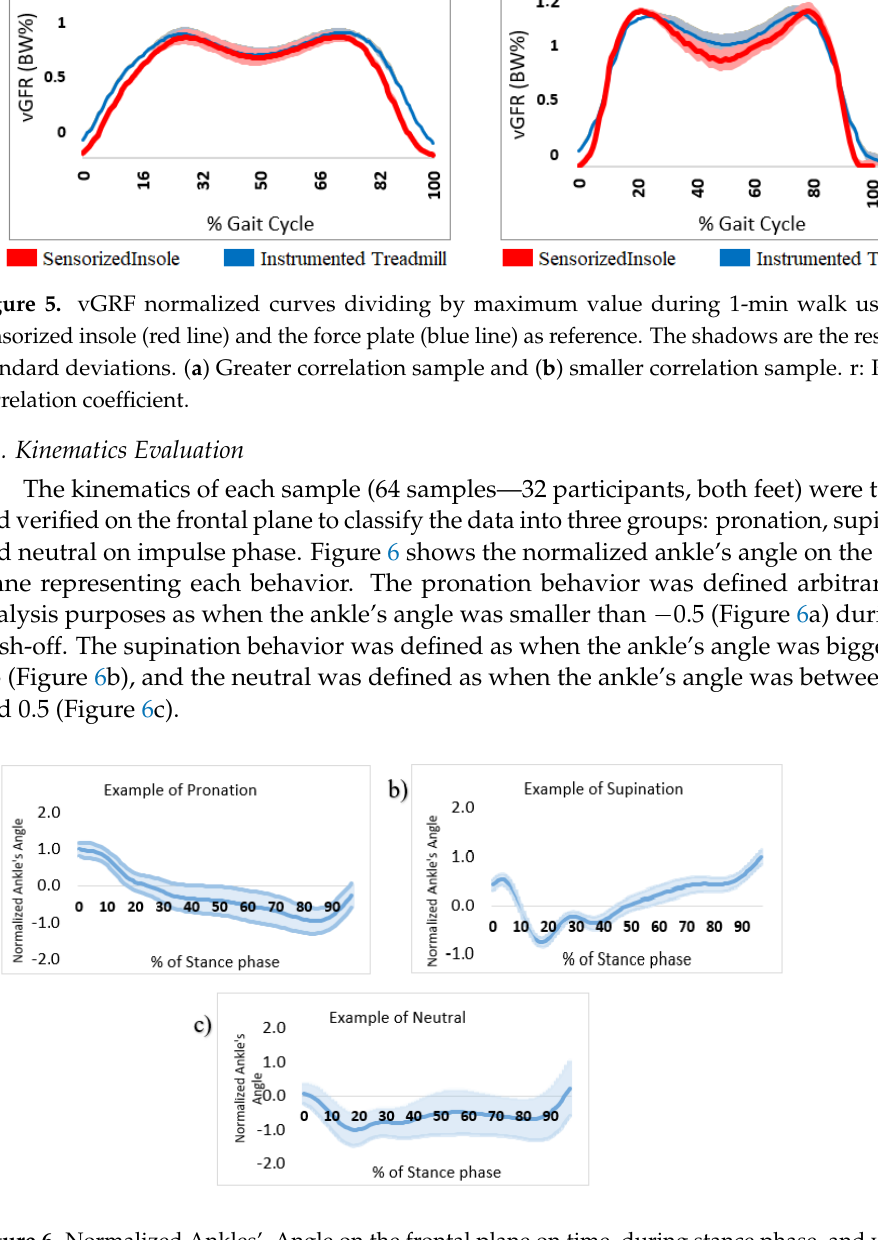
Figure 6. Normalized Ankles’ Angle on the frontal plane on time, during stance phase, and with the zero references on orthostatic position. Figure ( a ) shows an example of pronation, ( b ) supination, and ( c )